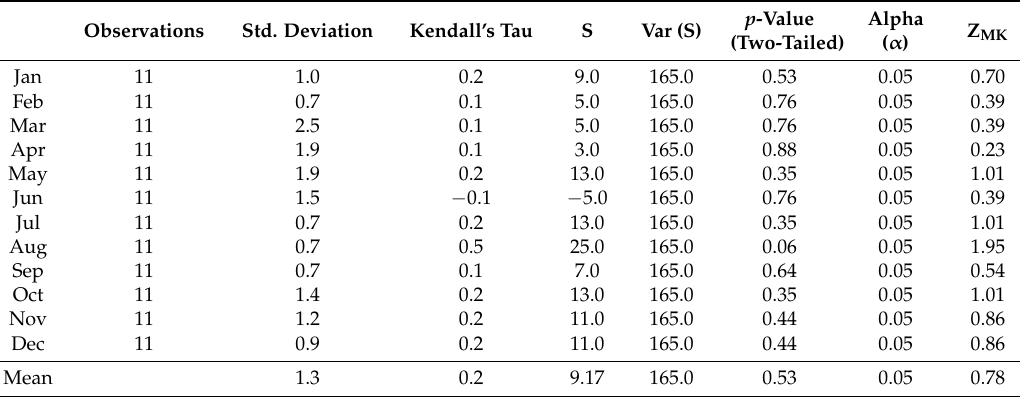
Table 3. Mann-Kendall test statistics for monotonic trend in